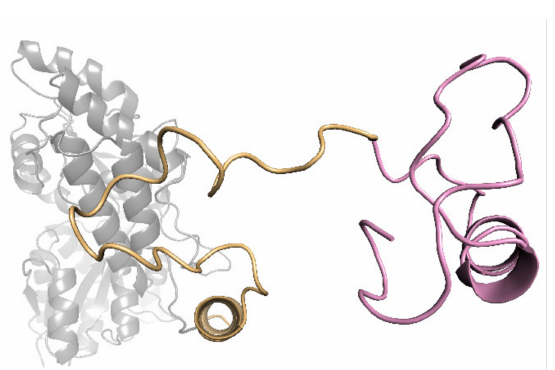
Figure A1. A modeled structure of the MBP-SPL2cyt protein. The orientation is as in Figure 1. MBP (gray), the linker region of SPL2cyt (gold), RING (pink).